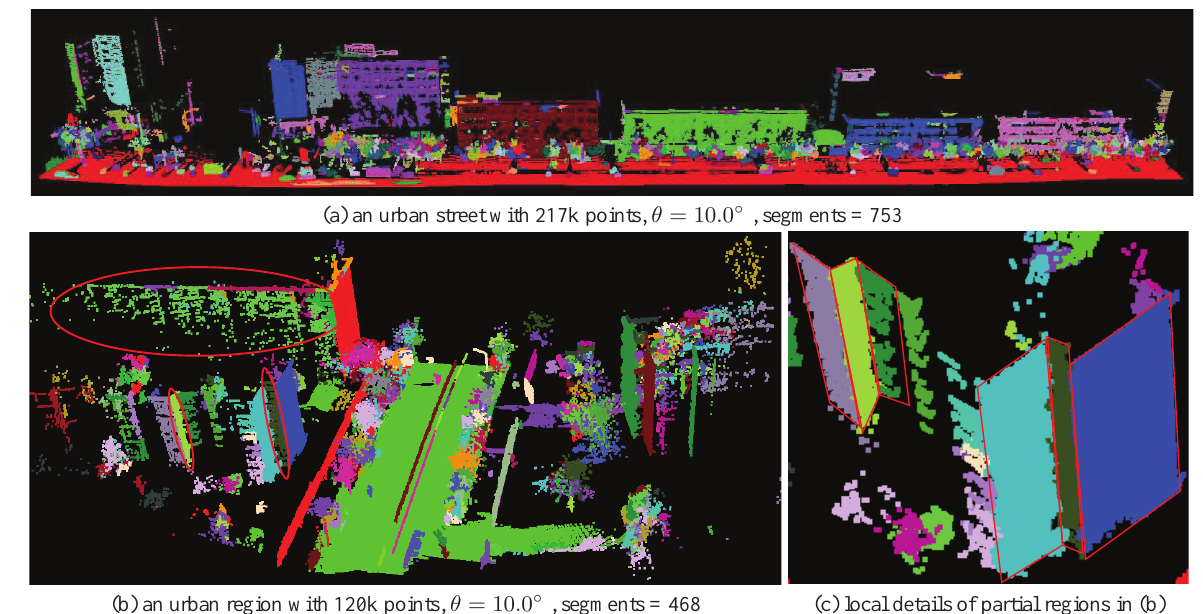
Figure 6: Segmentation results of the proposed method on the vehicle-mounted test data.